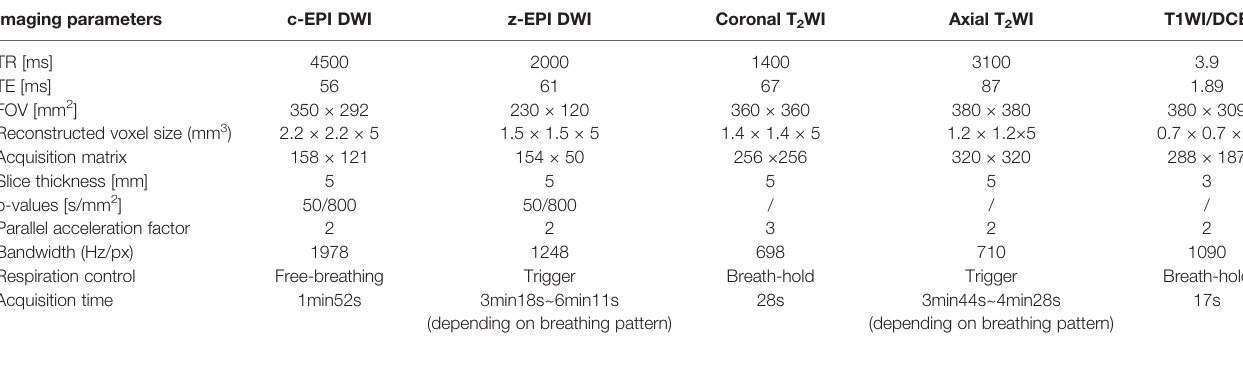
TABLE 1 | Magnetic resonance imaging parameters. Imaging